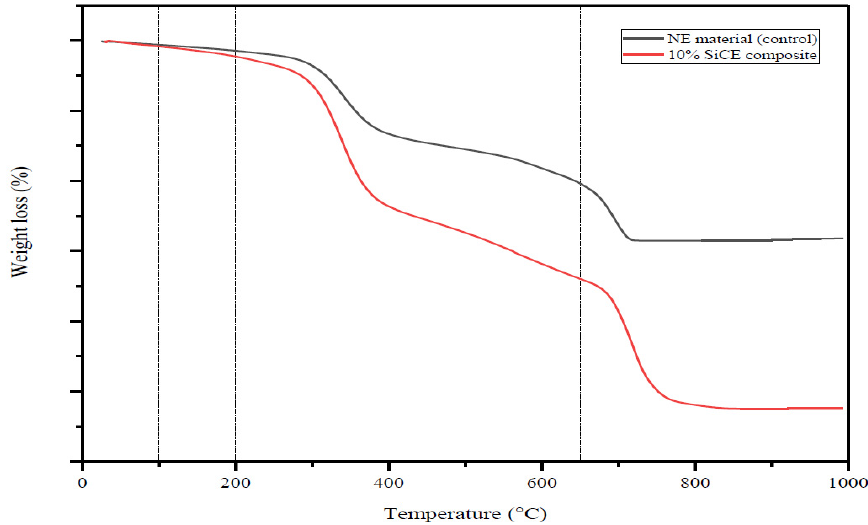
Figure 9. TGA analysis results of the processed epoxy matrix